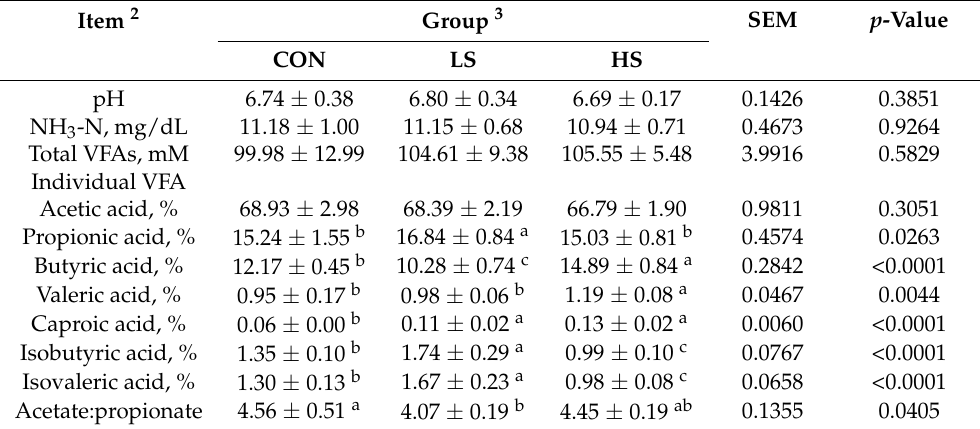
Table 2. Effect of selenium yeast on ruminal fluid fermentation parameters of goats 1